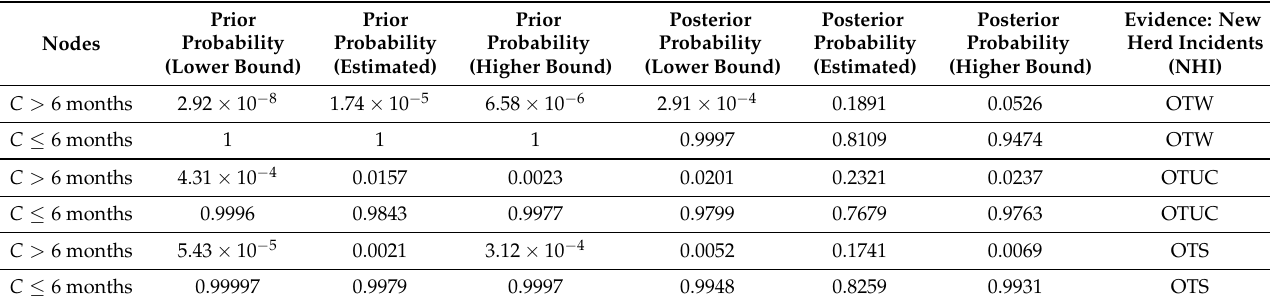
Table 5. Prior and posterior probabilities for node C in high-risk areas of England cattle farms.